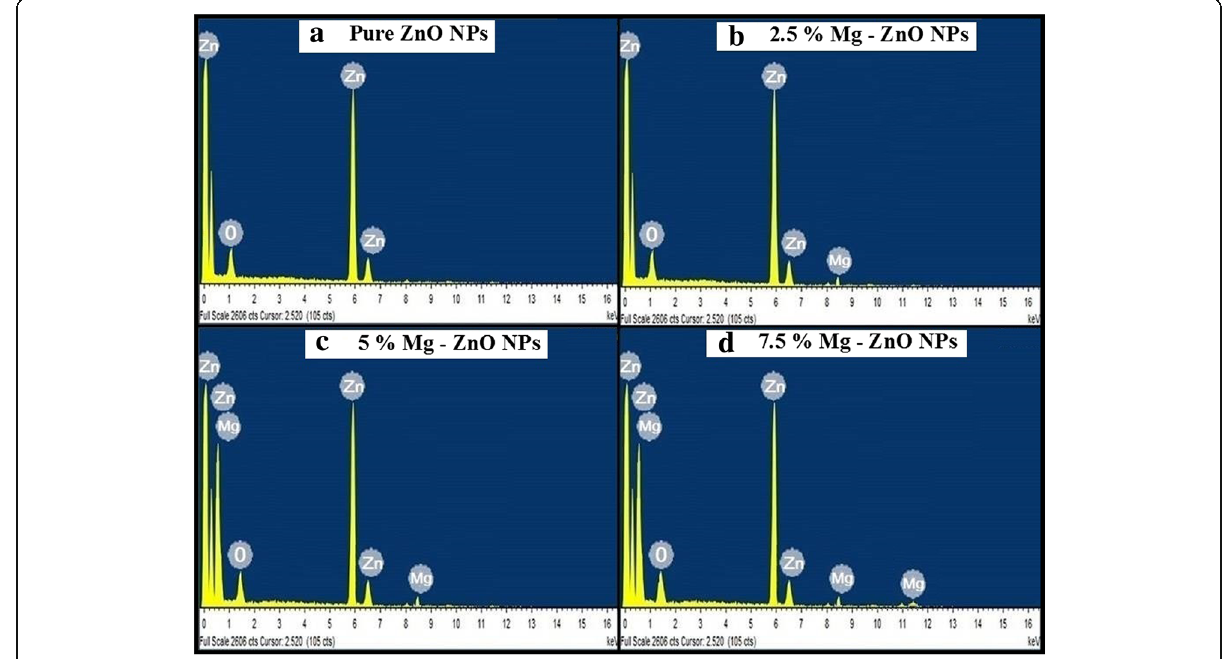
Fig. 4 Energy-dispersive X-ray (EDS) spectra. a Pure ZnO NPs. b 2.5% Mg-ZnO NPs. c 5% Mg-ZnO NPs. d 7.5% Mg-ZnO